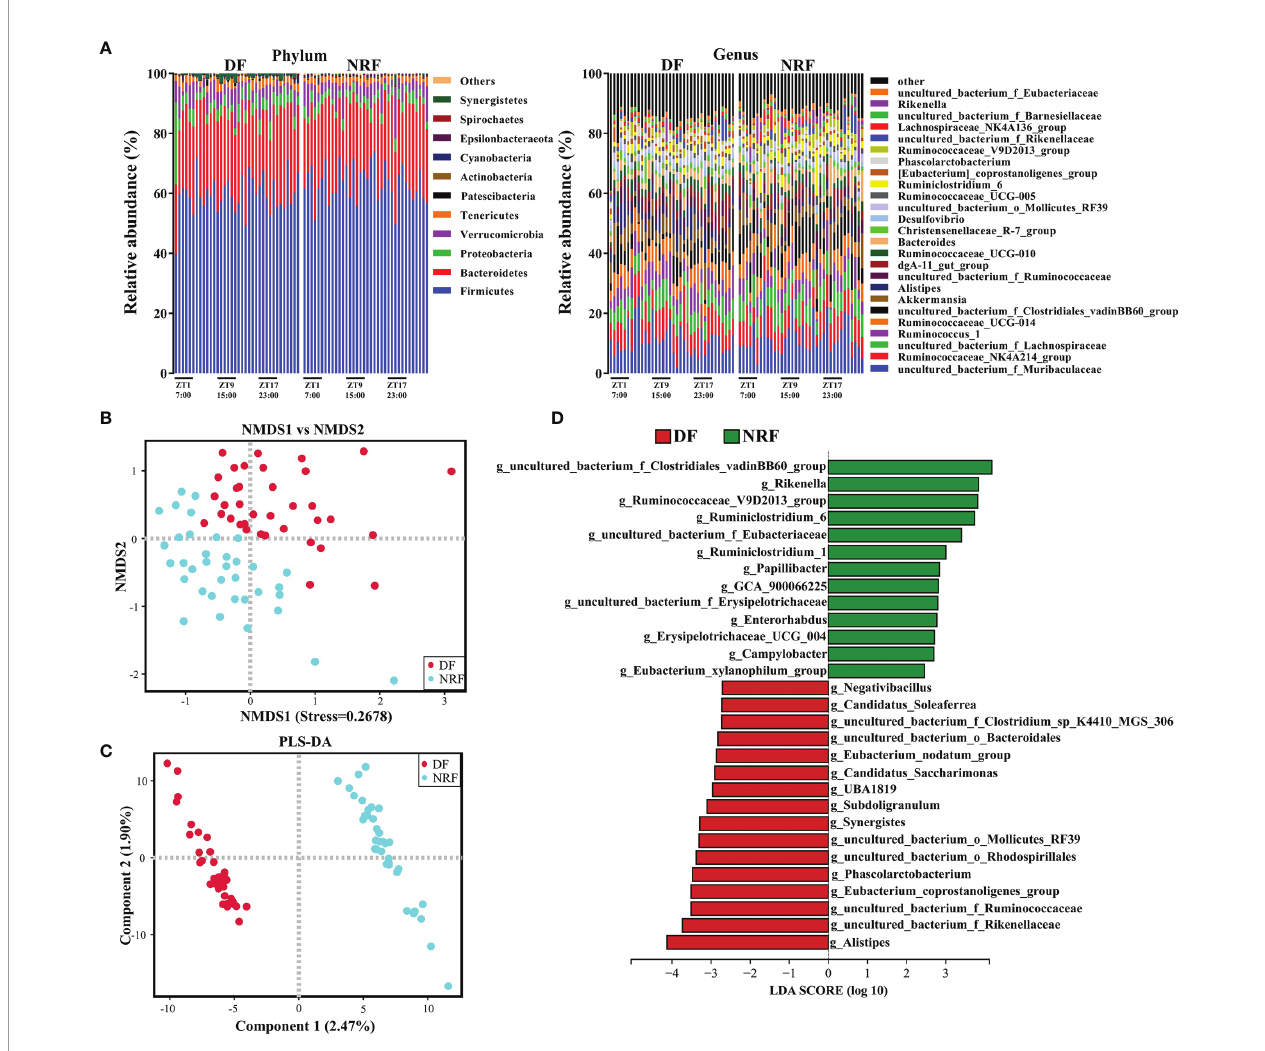
FIGURE 2 | Feeding time affects the composition and microbial diversity of the gut microbiota in growing rabbits. (A) The taxonomic composition of cecum microorganisms at the phylum level and genus level (1%, according to relative abundance) under different feeding time regimens. (B) Nonmetric multidimensional scaling (NMDS) and (C) PLS-DA analysis of the cecal microbe. (D) LEfSe analysis at the genus level (LDA > 2). DF, daytime feeding; NRF, night-restricted